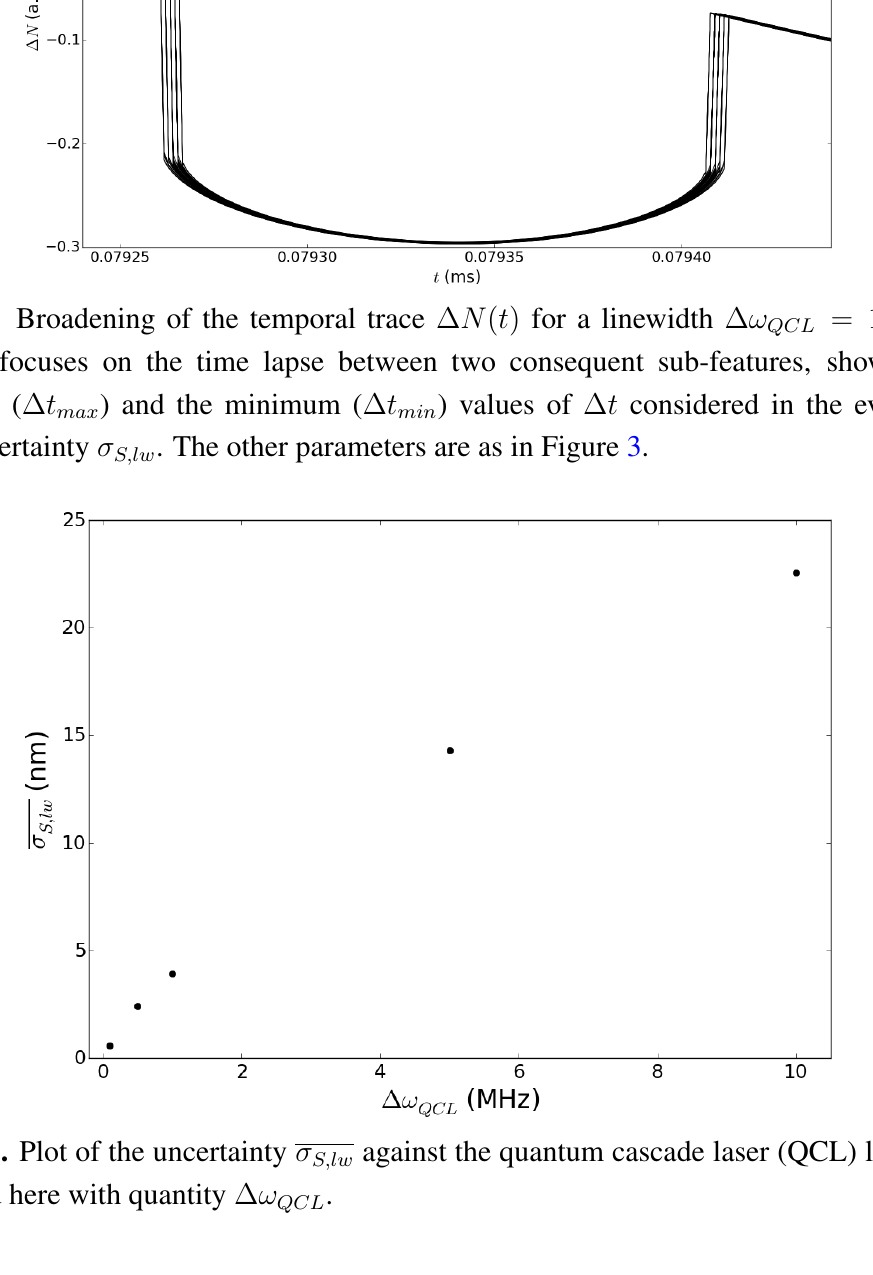
against the quantum cascade laser (QCL) linewidth S,lw QCL